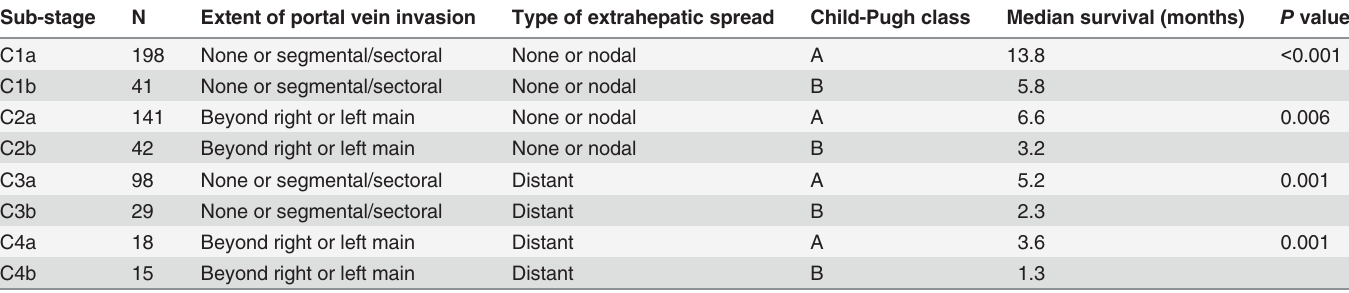
Table 3. Definition and survival of sub-classified Barcelona Clinic Liver Cancer stage